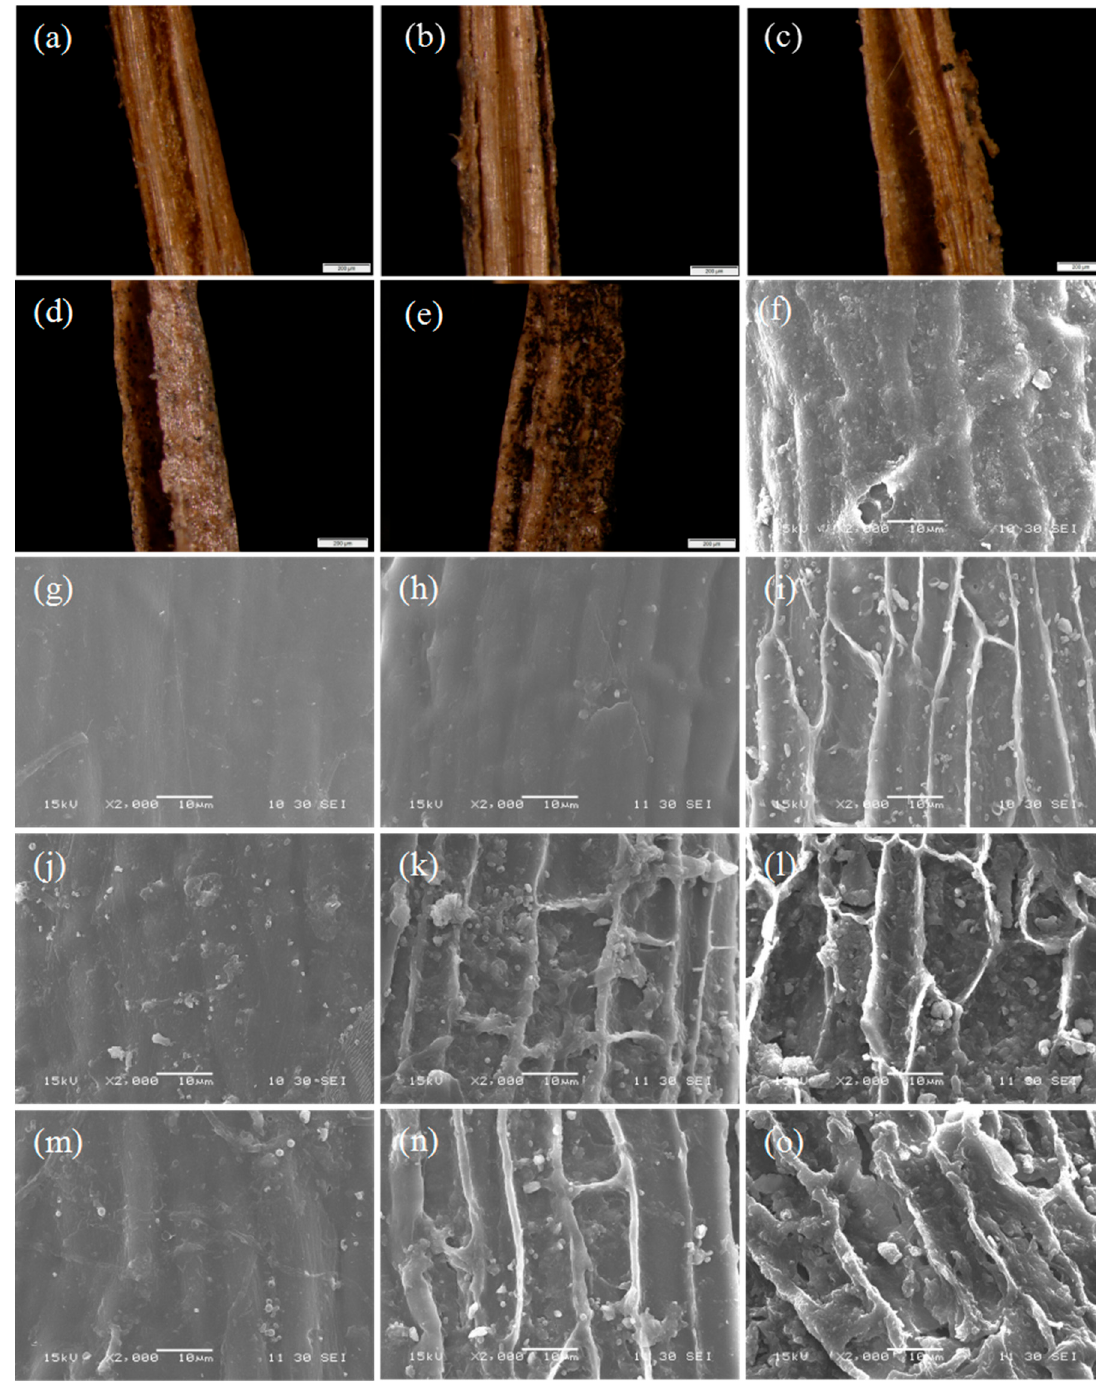
Figure 3. ( a – e ) are the longitudinal cross-sections of the five degradation processes of chestnut burrs (CB) during composting. ( a ) initial stage, mainly composed of three layers: surface layer, skeleton layer and innermost layer; ( b ) degradation of the innermost layer in treatment T9 on day 8; ( c ) degradation of the skeleton layer in treatment T9 on day 20; ( d ) a hollow structure in treatment T9 on day 31; ( e ) collapse of the CB spiny structure in treatment T9 on day 38. ( f – o ) show the scanning electron microscope (SEM) images of the tips of the CB outer epidermis at the end of composting of different treatments. ( f ) SEM micrograph of the tip of the initial CB, ( g – o ) SEM micrographs of the tips of the CB outer epidermis.